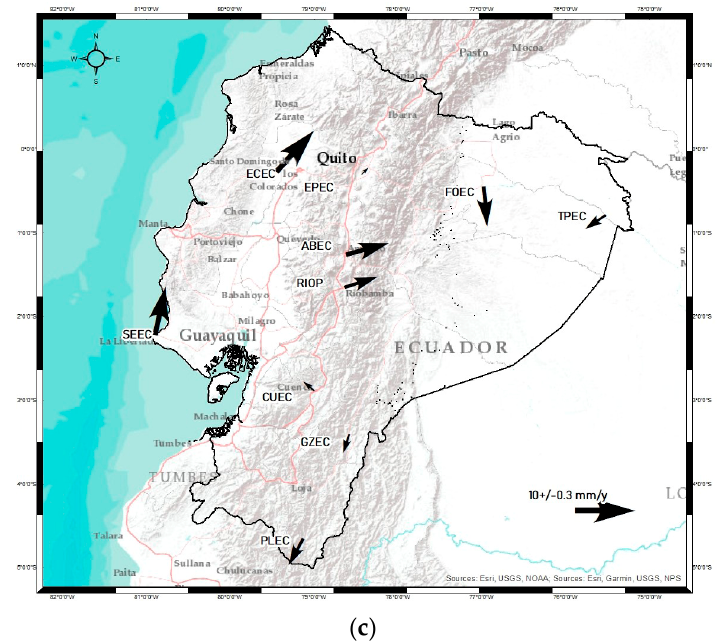
Figure 9. Velocity field from the position time series in the IGS14 reference frame. ( a ) Absolute horizontal rates, ( b ) vertical rates, ( c ) residual horizontal rates. The black arrows indicate the direction and magnitude of the movement, while at the tip of these arrows, there is a red circle that indicates the uncertainty of the movement calculated based on the noise analysis at each station.